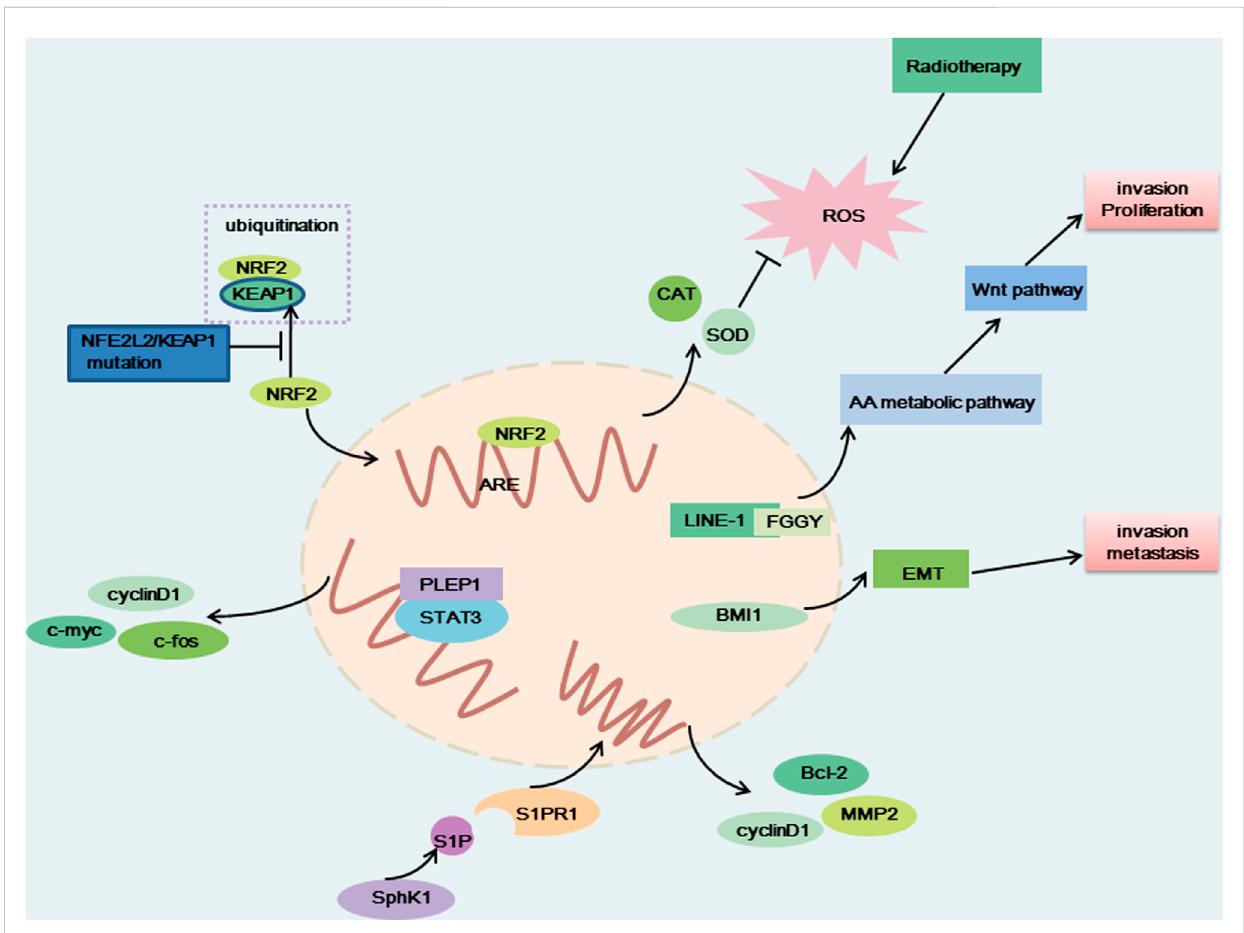
FIGURE 3 The carcinogenic effect of NFE2L2/KEAP1 mutation, PELP1, LINE-1-FGGY, SphK1 and BMI1. When NFE2L2/KEAP1 was mutated, NRF2 cannot be degraded, and NRF2 binds to antioxidative response element (ARE) to produce antioxidant factors that resist the therapeutic effects of radiotherapy. LINE-1-FGGY promotes cell proliferation and invasion by in fl uencing the AA metabolic pathway as well as the Wnt pathway. BMI1 promotes cell transfer and invasion by in fl uencing EMT. The binding of PELP1 to STAT3 promotes the expression of c-myc, cyclin D1, c-fos, and thus promotes cell proliferation. Elevated SphK1 activity promotes S1P production, which binds to corresponding receptors and promotes the production of Bcl-2, MMP2 and cyclin D, thereby promoting cell proliferation and